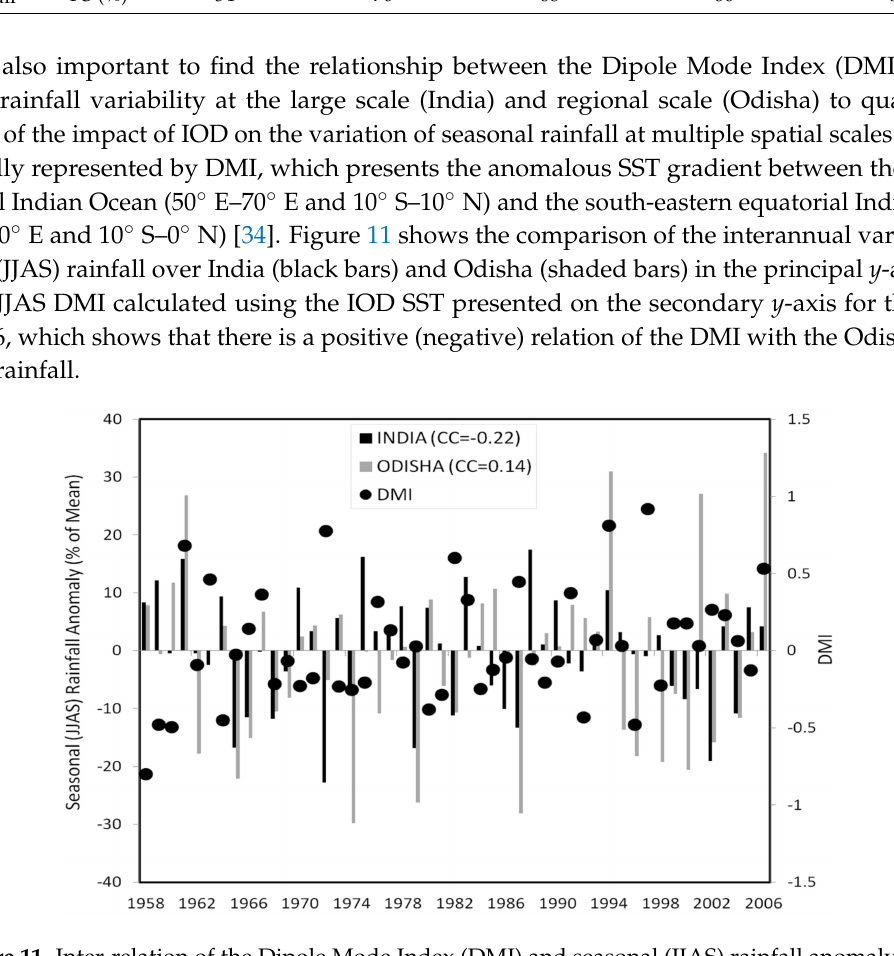
Figure 11. Inter-relation of the Dipole Mode Index (DMI) and seasonal (JJAS) rainfall anomaly over India and Odisha for the period 1958–2006. The correlation of the seasonal rainfall anomaly and the DMI anomaly are given in